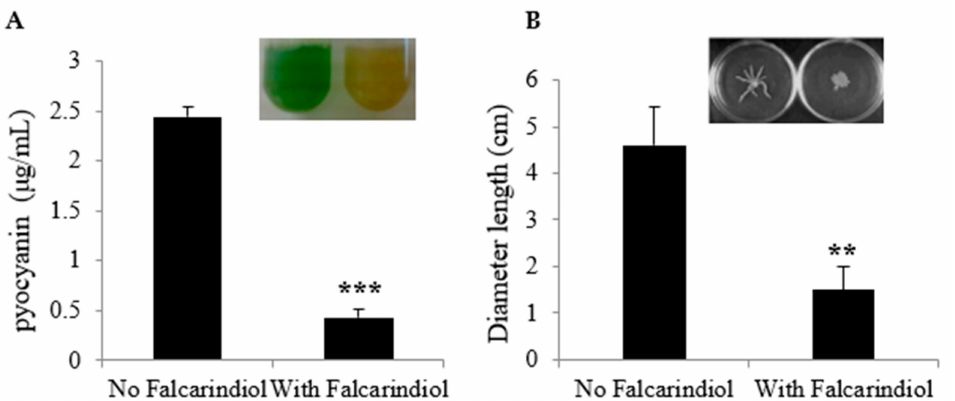
Figure 4. The e ff ect of falcarindiol on pyocyanin production ( A ) and swarming motility ( B ). Pyocyanin production and swarming motility were measured in the presence of 32 µ g / mL falcarindiol. Note: *** p < 0.001, ** p < 0.01. The images of the cultures and swarming motility tests are shown as